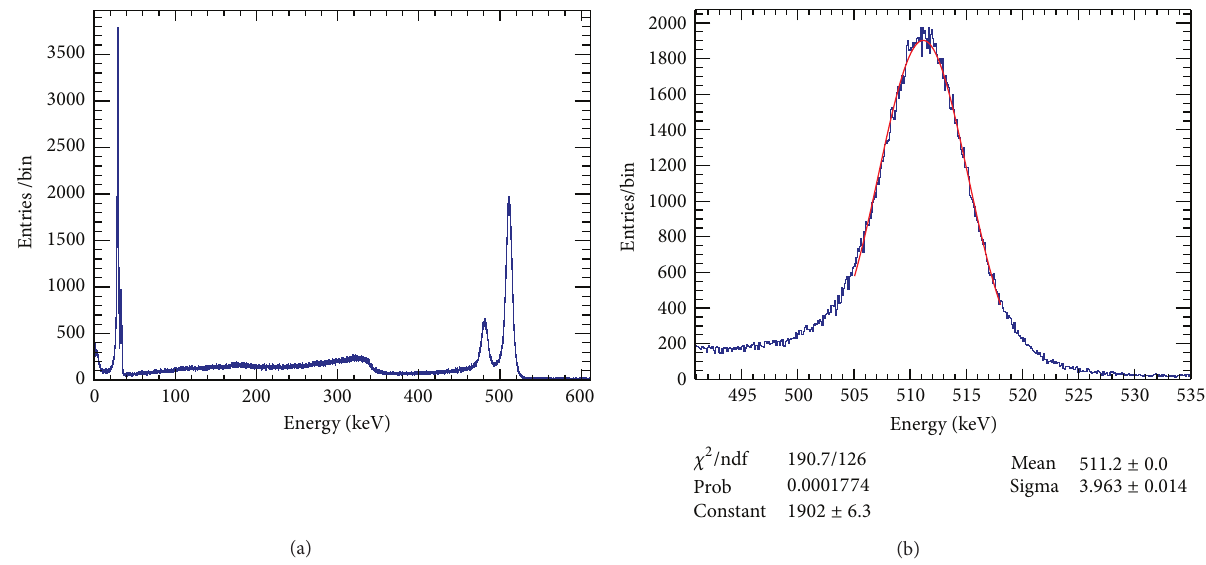
Figure 27: Energy spectra for 22 Na gamma-ray events within the fiducial volume of NEXT-DEMO. (a) The whole spectrum. (b) Zoom-in the photoelectric peak [41].